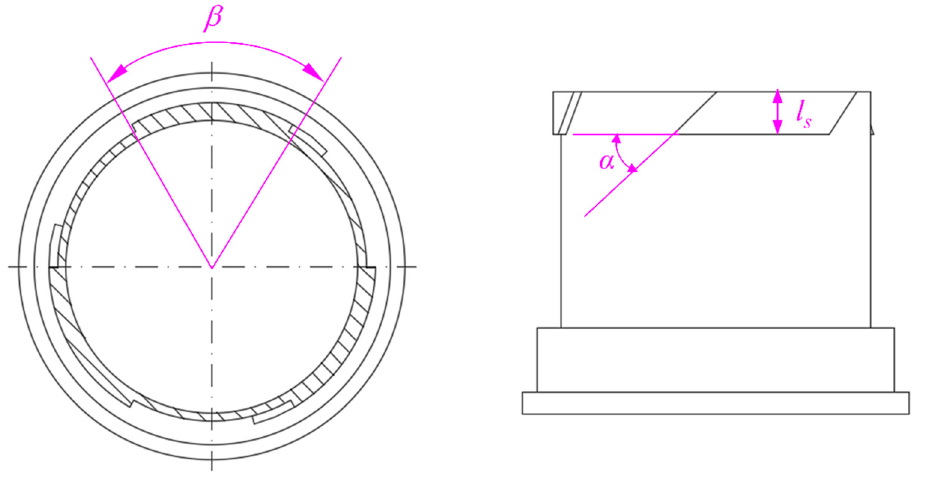
Figure 2. Structure of the swirler. Table 2. Structure parameters of the swirler. Table 2. Structure parameters of the